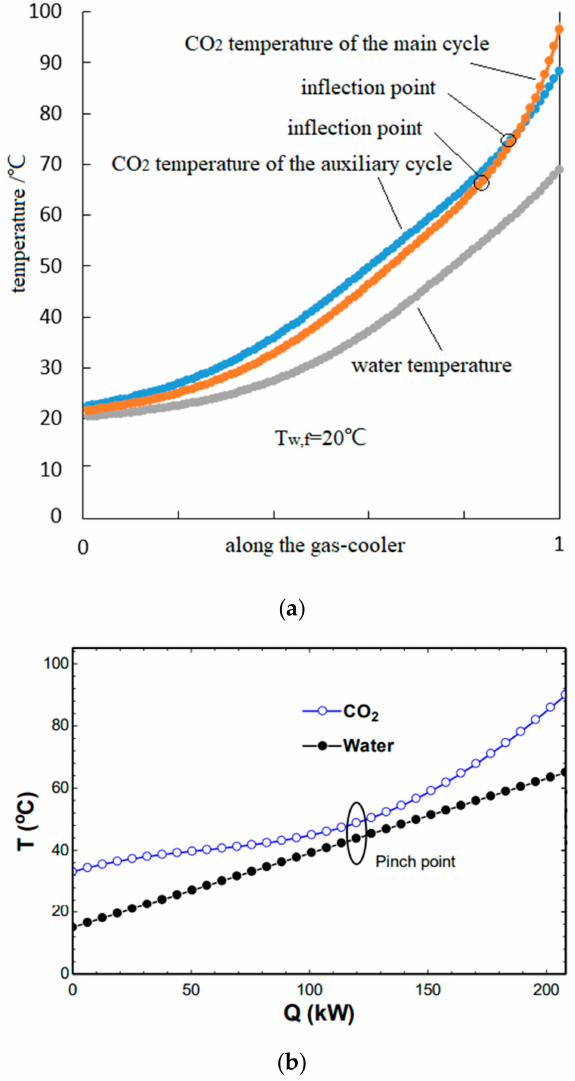
Figure 10. ( a ) The temperature distribution of the combined gas cooler; ( b ) the pinch point location inside the gas cooler